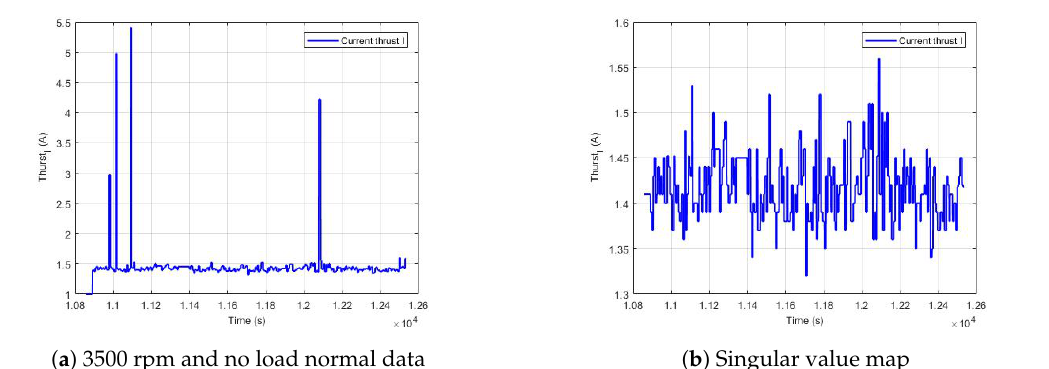
Figure 11. Data for 3500 rpm and no load normal, and singular value map.